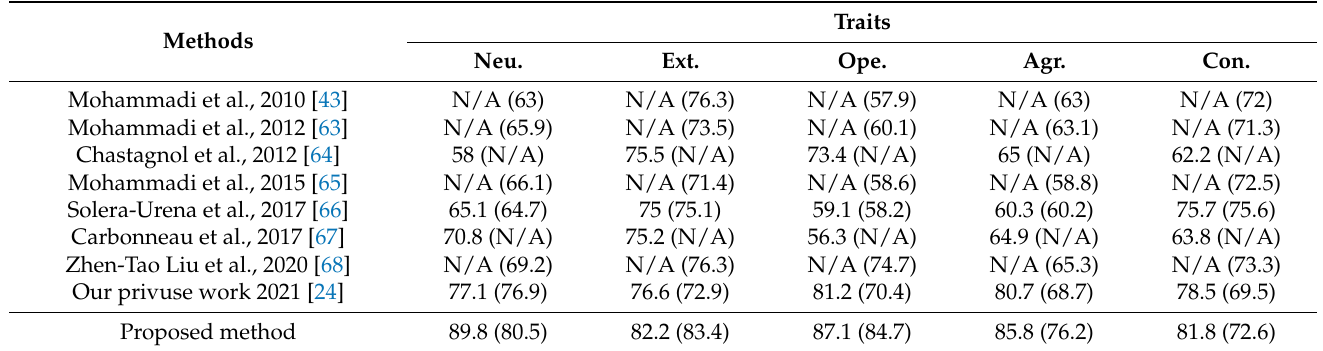
Table 5. Comparison Results of Our Proposed Method with Other Works in the SPC Dataset in Terms of UA Recall % (Accuracy